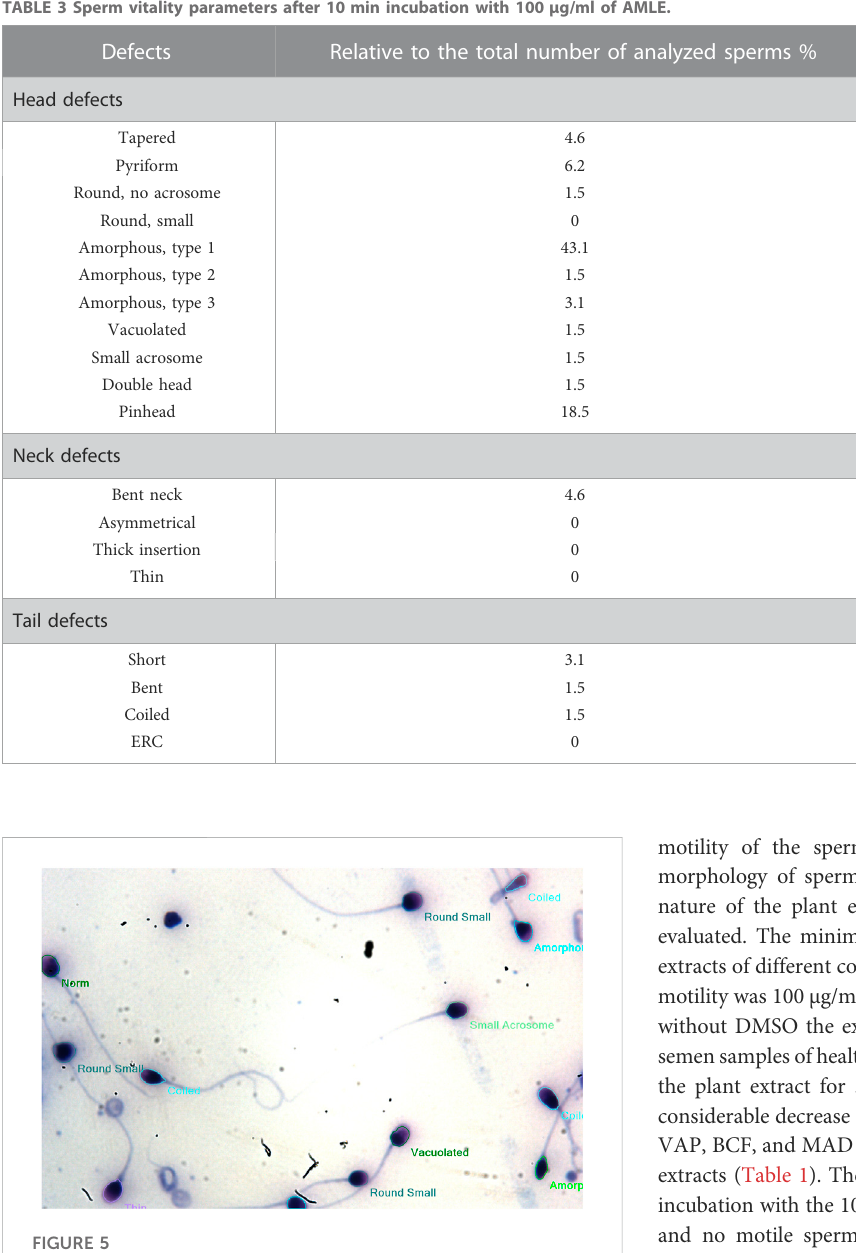
Table 2). The sperm morphology modi fi cations and vitality changes